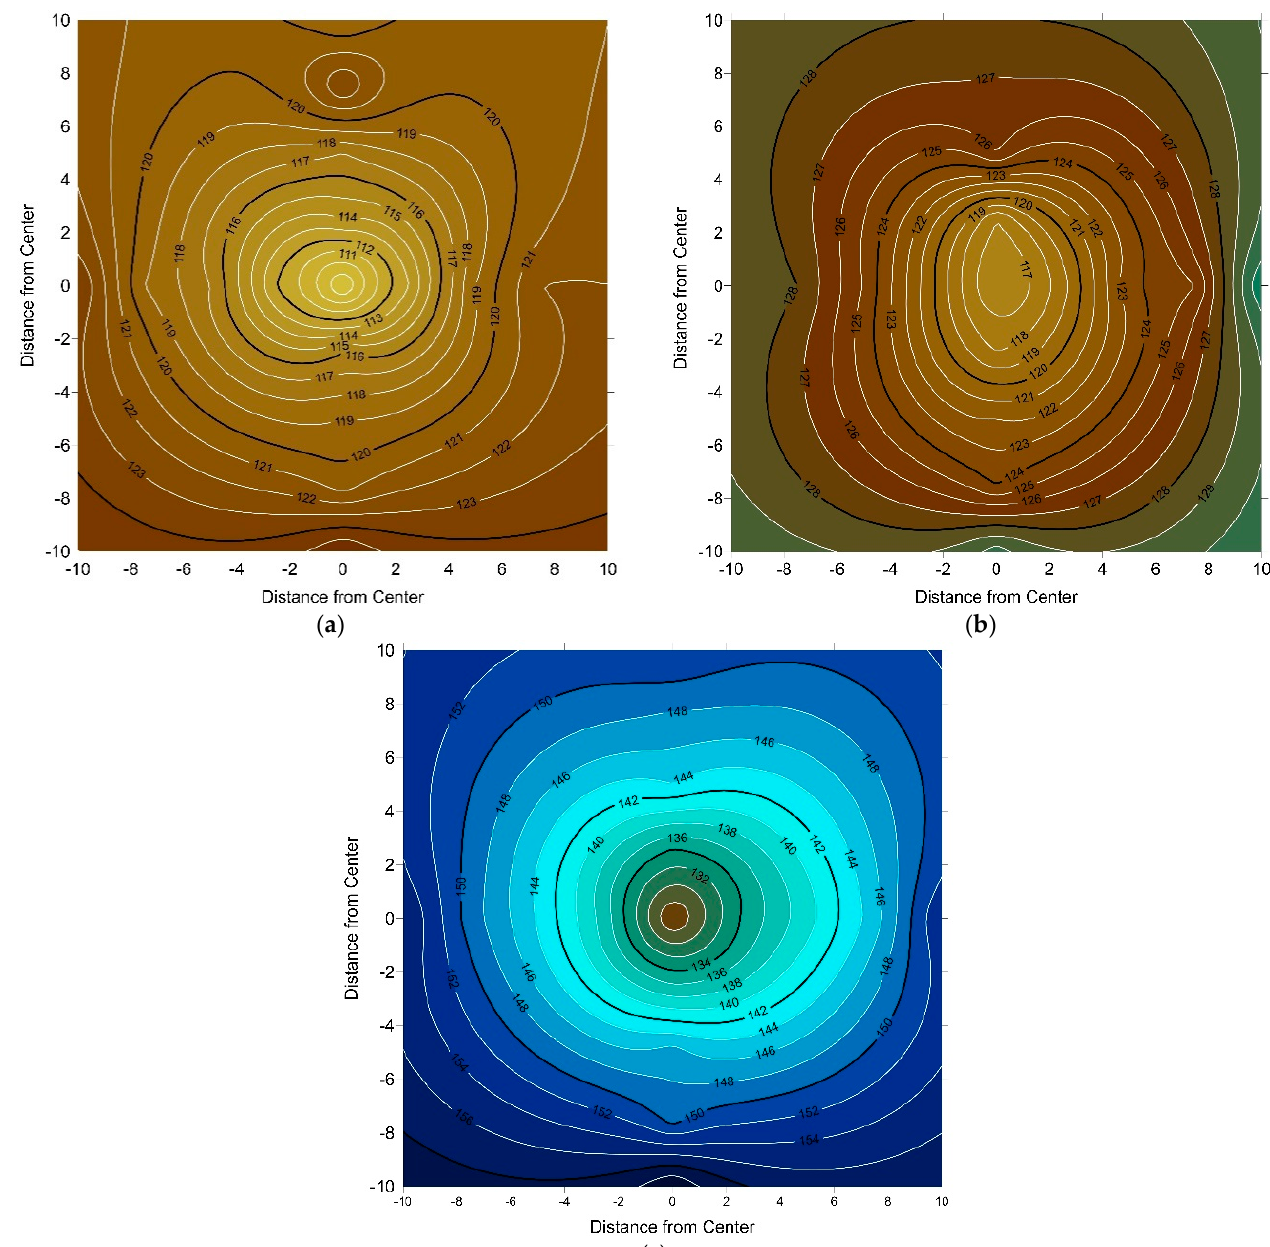
Figure 14. Color coded contour for the hardness values recorded on the transverse section (TS) of the Cu billets processed via ECAP processing after ( a ) 1-P, ( b ) 2-Bc and ( c ) 4-Bc.